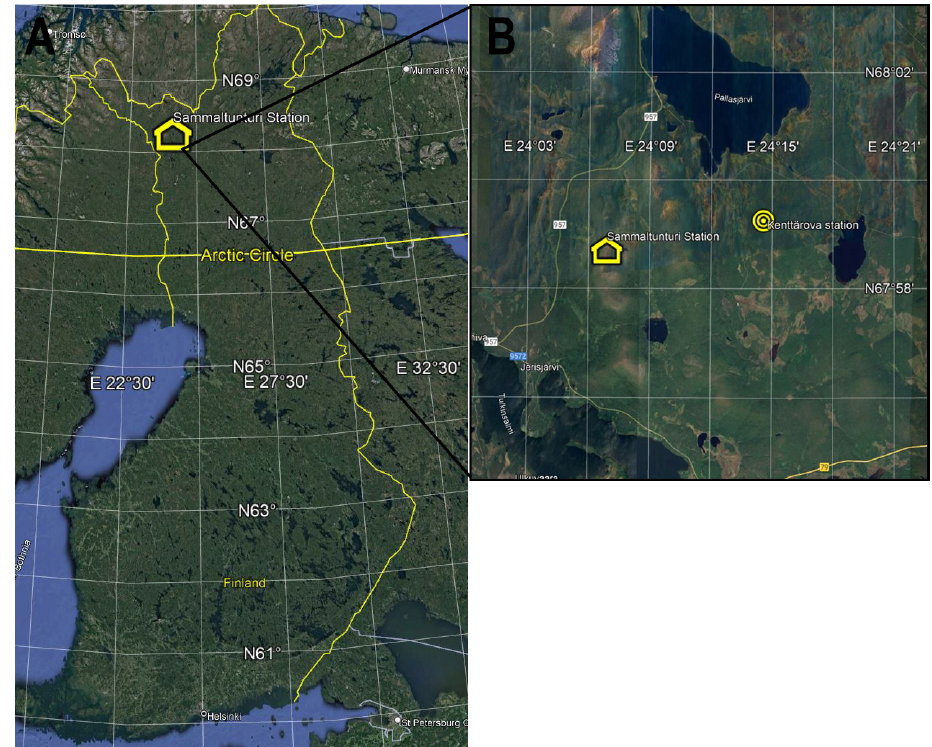
Figure 1. (a) Map of Finland showing the location of the Pallas Atmosphere-Ecosystem Supersite (yellow hut) and (b) map of the wider Pallas area showing the location of Sammaltunturi (yellow hut) and Kenttärova (yellow circles) stations (©Google Maps).